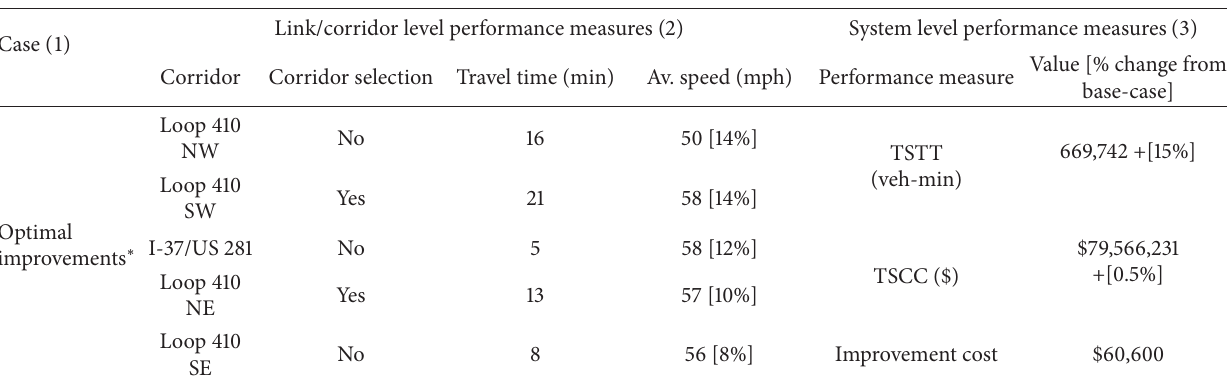
Figure 2: Flowchart illustrating solution methodology. Table 3: Result of analysis of example